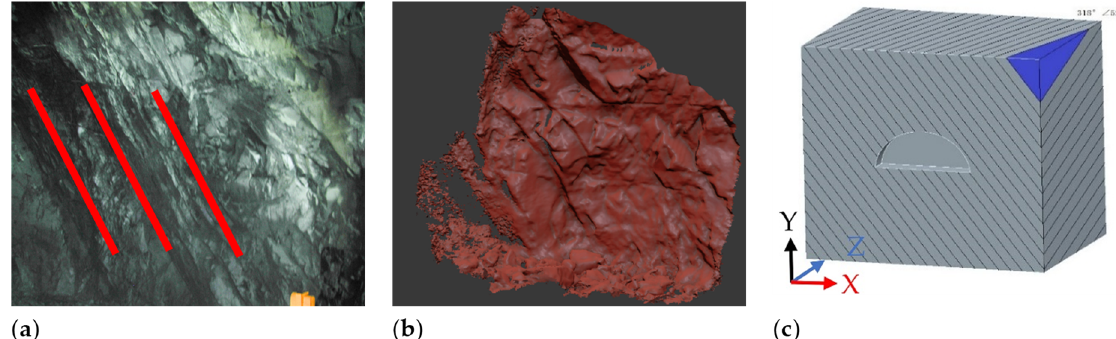
Figure 5. Monitoring section DK 152 + 875–DK 152 + 902 structural surface information: ( a ) visible light photo of the rock wall; ( b ) 3D scan of the rock wall; and ( c ) geometric model.